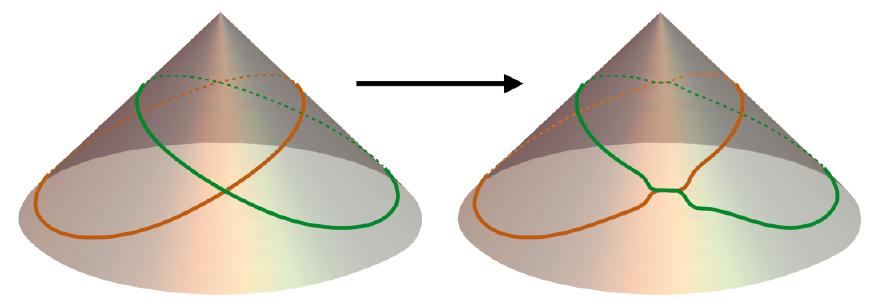
Figure 5 . Deformations of spheres to smooth out intersections and unions on the